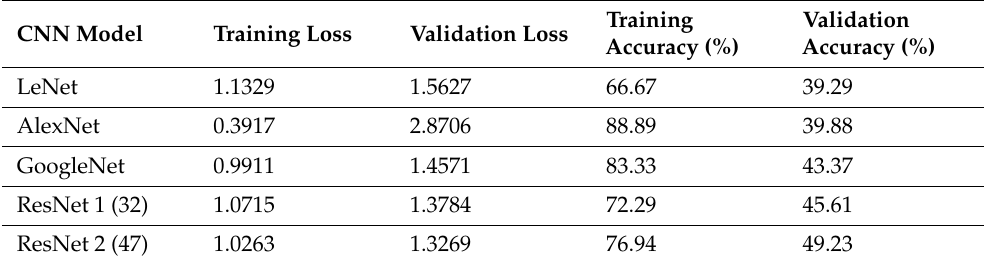
Table 2. Results using minerals segmentation used in [22] with different CNN